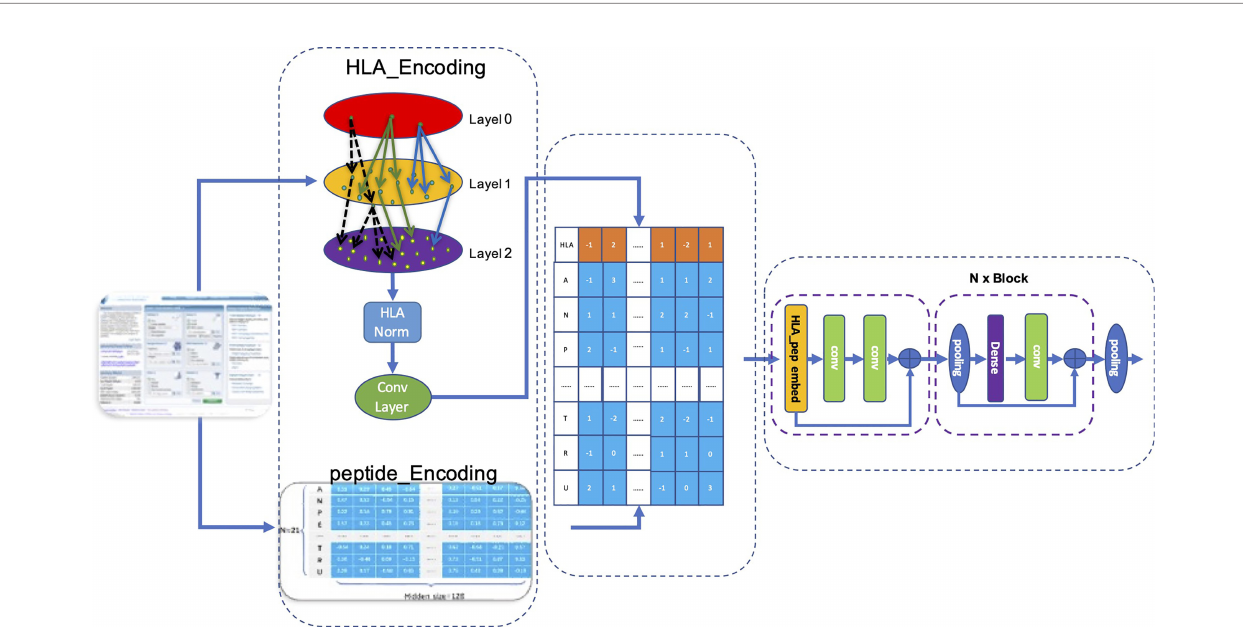
FIGURE 4 | Architecture of FIONA. The dataset is downloaded from the IEDB database according to Section 2.1. The fi rst dotted box contains an HLA_head and peptide, which are encoded separately and then integrated for feature transformation. The middle part contains an HLA_head, and peptide_Embedding represents sequence feature information. The right dotted box is our CNN model for training and